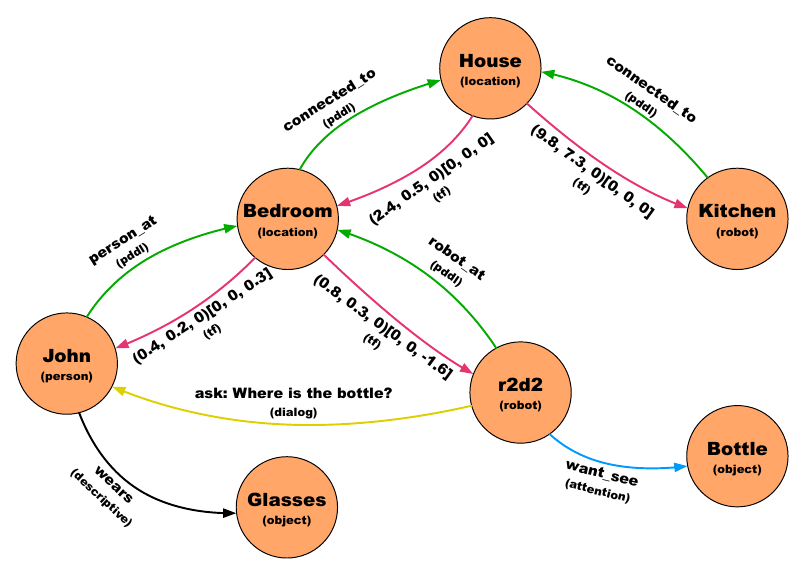
Figure 6. Knowledge representation as a